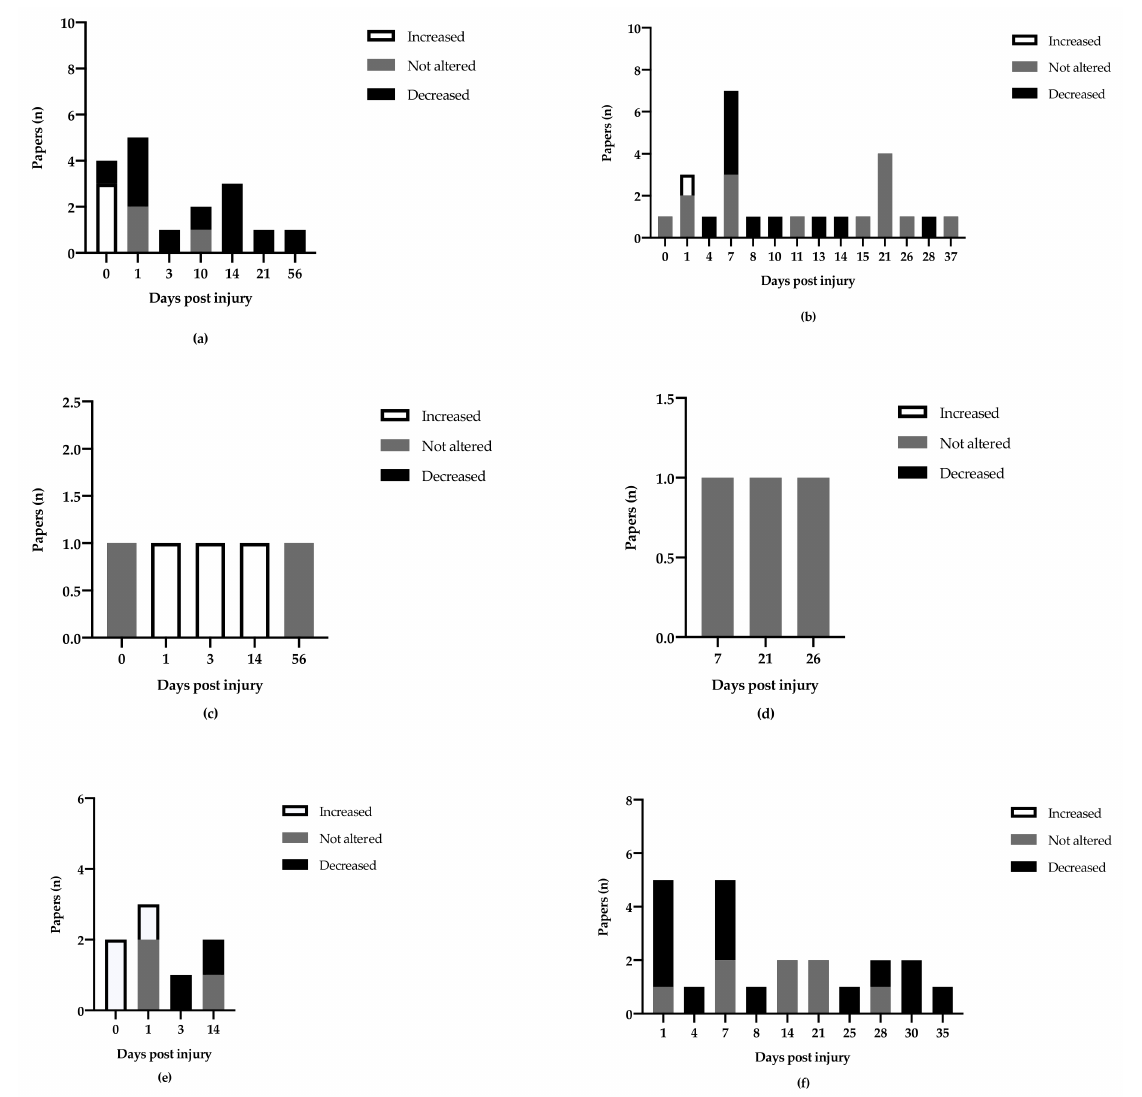
Figure 3. Overview of the number of timepoints in which brain derived neurotrophic factor (BDNF) expression was examined in the reviewed material, and whether TBI significantly increased, decreased, or was not significantly altered BDNF expression compared to sham-injured animals. ( a ) BDNF mRNA expression in the ipsilateral hippocampus. ( b ) BDNF protein expression in the ipsilateral hippocampus. ( c ) BDNF mRNA expression in the contralateral hippocampus. ( d ) BDNF protein expression in the contralateral hippocampus. ( e ) BDNF mRNA expression in the ipsilateral cortex ( f ) BDNF protein expression in the ipsilateral